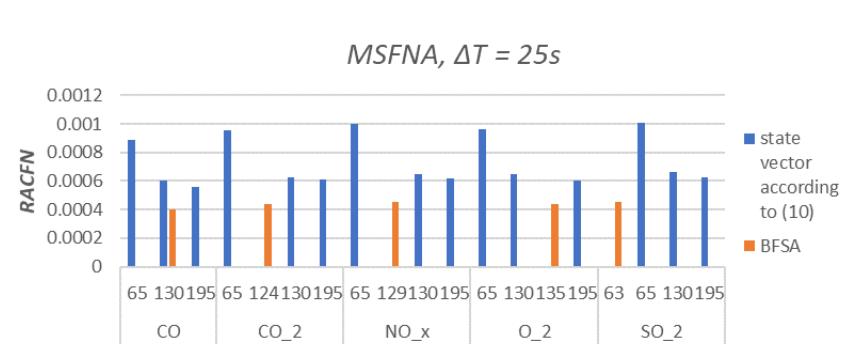
Figure 9. Relative Areal Cumulative False Neighbors RACFN for sampling periods ∆ T = 25 s. Orange columns are state vectors proposed by BFSA and blue columns are state vectors created according to (11) with n ui = n yj = [ 5, 10, 15 ] . Axis x represents the